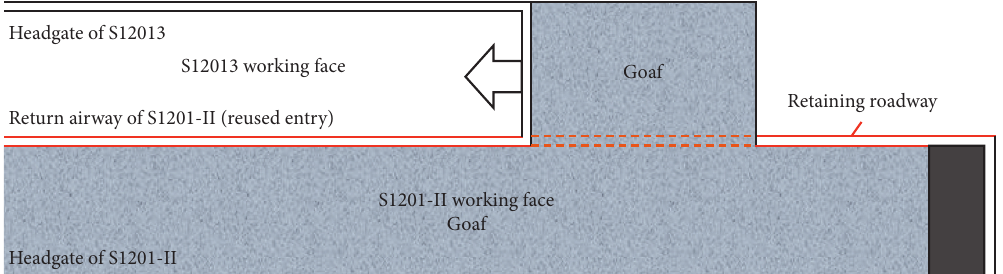
Figure 1: Roadway layout of the test working face.